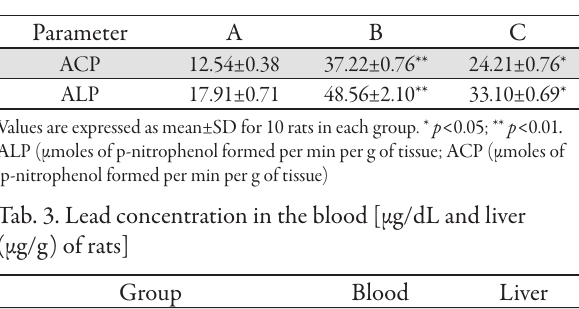
Tab. 2. Protective effect of vitamin C on hepatic biochemical parameters in rats